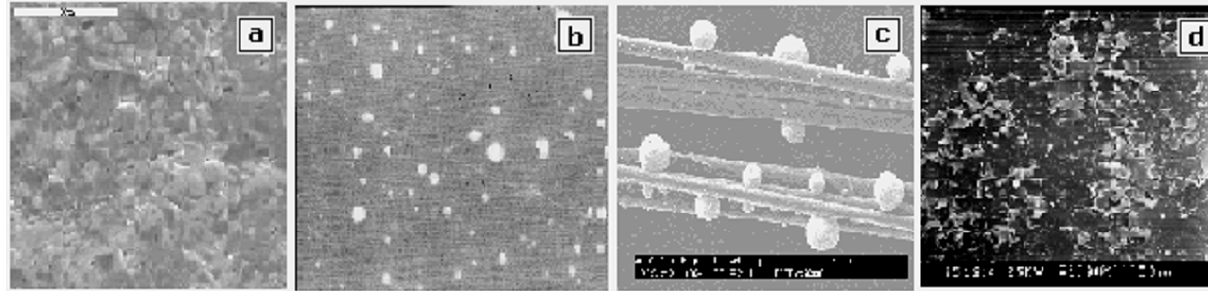
Figure 1. Scanning Electron Micrographs (at 8 kV) of Hg and Pb particle distribution on the different deposit surfaces: (a) Hg (4mM/gold), (b) Hg (4mM/GCE), (c) Hg (4mM/CFE), (d) Pb (6 mM)/GCE.